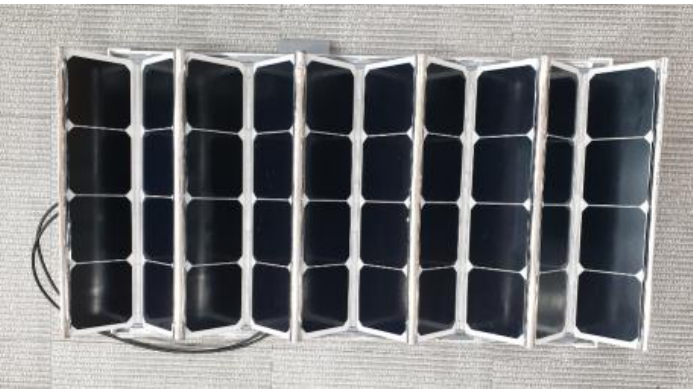
Figure 5. Intelligent solar module.